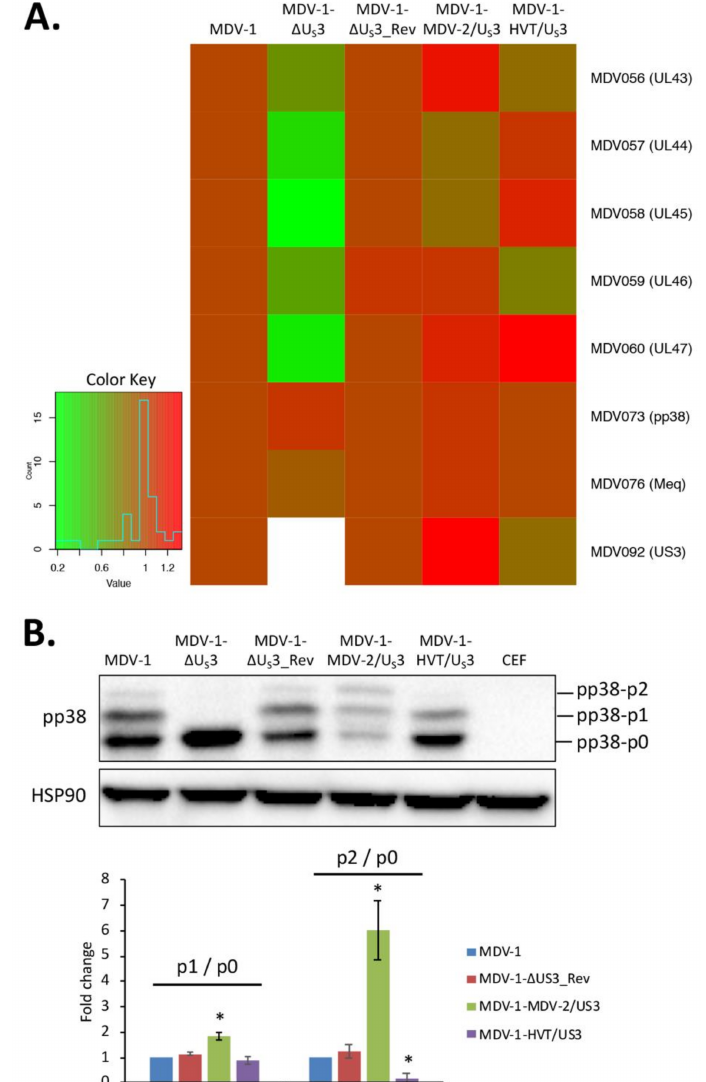
Figure 2. U S 3 of MDV-1, MDV-2, and HVT differentially regulate viral gene expression. Chicken embryonic fibroblasts (CEF) seeded on 60 mm dishes were infected with 300 plaque-forming units (PFU) of the different viruses or remained uninfected as negative control. Seven days later, cells were harvested for RNA, DNA and protein isolation. ( A ) Gene expression analysis. The extracted genomic DNA was used to determine MDV-1 genome copy number. Total RNA extracted from infected CEF were subjected to cDNA synthesis, followed by quantitative polymerase chain reaction (qPCR) to measure the expression of the indicated MDV-1 genes. The data were analyzed by the 2 − ∆∆ CT method using chicken GAPDH as the internal control and normalized to MDV-1 genome copy number. The relative average fold changes of each gene from two independent experiments are presented as heat map, where red indicates upregulation and green indicates downregulation. ( B ) Analysis of pp38 protein expression. Proteins extracted from infected and uninfected CEF were subjected to sodium dodecyl sulphate-polyacrylamide gel electrophoresis (SDS-PAGE), followed by Western blot analysis with antibodies to MDV pp38 and chicken HSP90 protein, as loading control (upper panel). Phosphorylated pp38 proteins (pp38-p1 and pp38-p2) were quantified with Image J, normalized to unmodified pp38 protein (pp38-p0) and presented as average fold changes, from two independent experiments, of p1 to p0 (bottom graph, left) and p2 to p0 (bottom graph, right) ratios relative to the value derived from parental MDV-1-infected cells. Error bars represent standard deviation (SD). The statistical difference between values derived from parental MDV-1 infected cells and those from other groups was analyzed using a t -test. *: p <